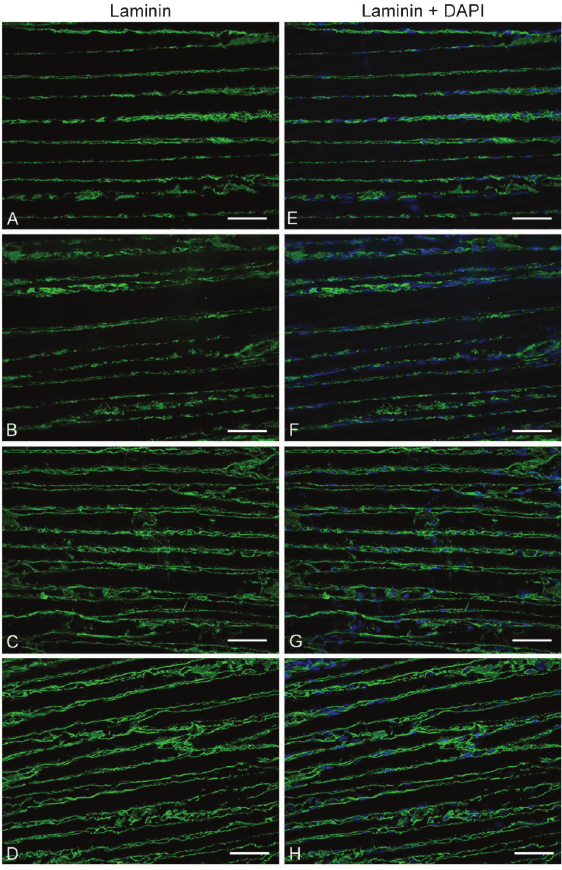
Figure 5. Photomicrographs of the soleus muscle of the animals in groups C (Immob) , I, IF (1) , and IS (1) , A - H : Longitudinal sections immunolabeled with rabbit polyclonal anti-laminin (green fluores- cence) antibody, nuclear fluorescent staining defined by DAPI (blue fluorescence). A [C (Immob) ]: Staining for laminin without alterations. B (I): Staining thickness. C [IF (1) ) and D [IS (1) ]: Larger number of fibers in the area and staining thickness. E [C (Immob) ], F (I), G [F (1) ], and H [IS (1) ]: Merged images of laminin and DAPI. Observe the localization of the nuclei (in blue). See Figure 1 legend for explanation of abbreviations. Scale bars: 50 m m.